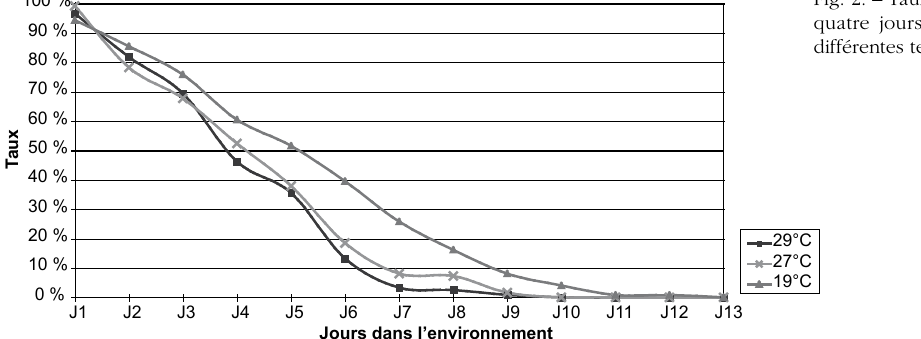
Fig. 2. – Taux de survie de C. f. strongylus de quatre jours d’âge, à jeun, en fonction de différentes